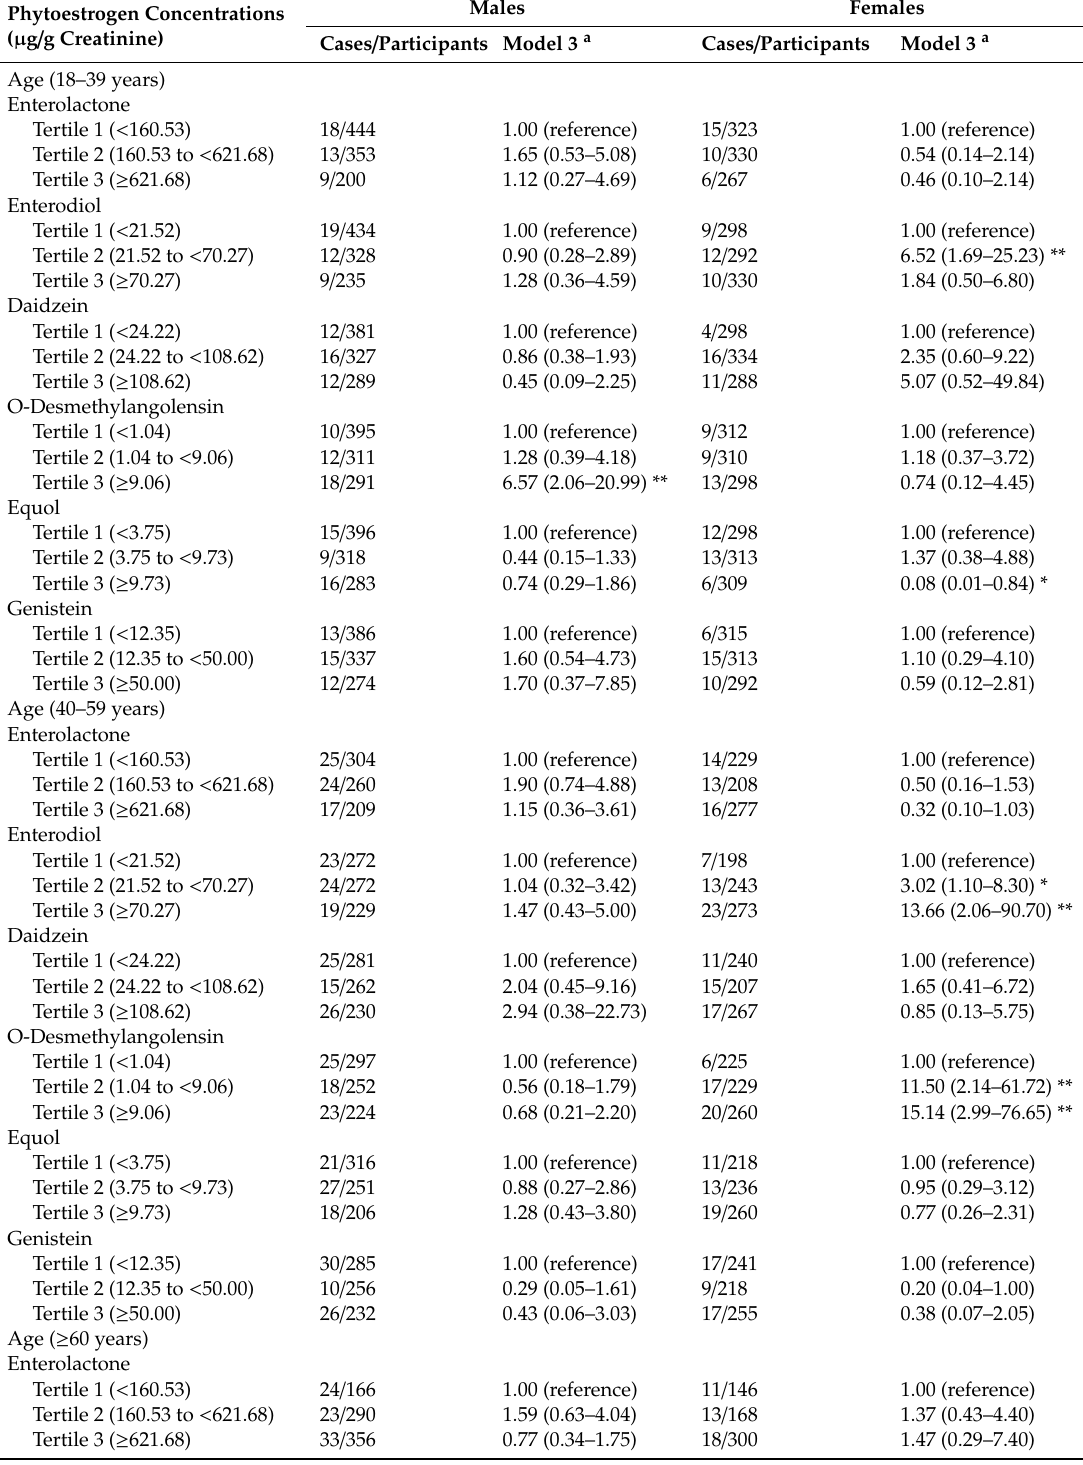
Table 5. Weighted odds ratios (95% confidence intervals) for sleep disorders across tertiles of urinary phytoestrogen concentrations stratified by age for males and females (National Health and Nutrition Examination Survey